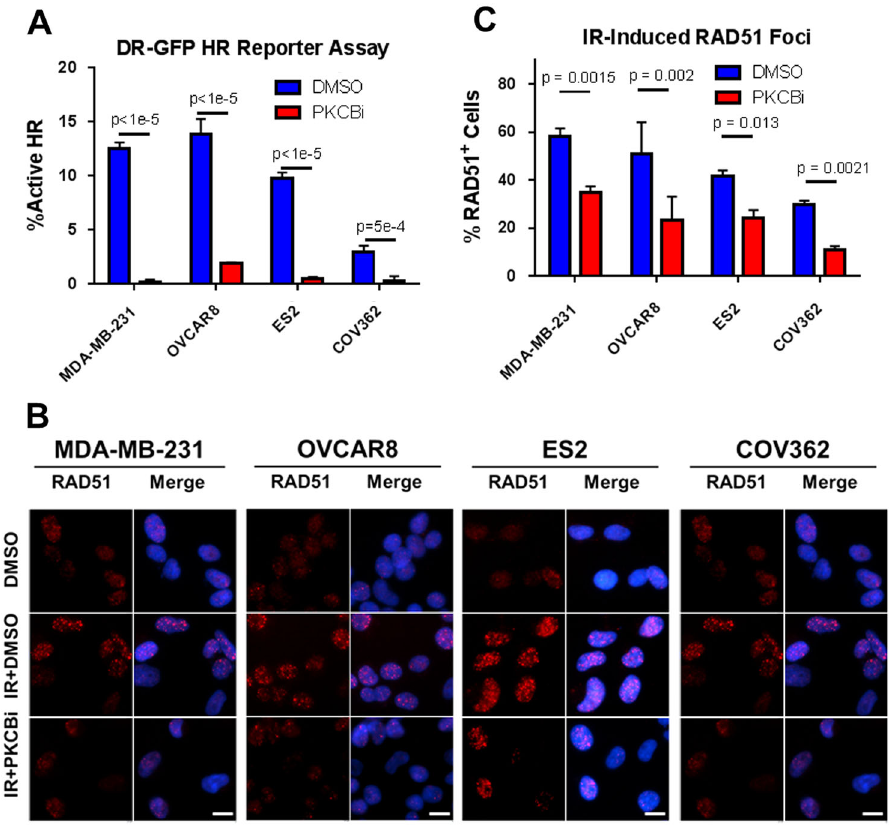
Fig. 5 PKC β inhibition induces de fi ciencies in homologous recombination. a DR-GFP homologous recombination (HR) reporter assay, where GFP induction is induced in cells with active HR following dual transfection with the DR-GFP and the pCBA-SceI. The day after transfection, cells were treated with either 5 μ M LY317615 or DMSO vehicle control for 48 h. The percentage of cells with active HR was calculated as the percentage of DR-GFP positive cells normalized to percentage GFP positive cells transfected with an equimolar amount of pEGFP-C1. b Reduction in radiation-induced Rad51 foci formation shows inhibited HR. Cells were pre-treated with 5 μ M LY317615 for 4 h, irradiated at 5 Gy, and then allowed to recover for 4 h before immunostaining for Rad51 ( red ) and nuclei ( blue ). Scale bar = 10 μ m. c Quanti fi cation of images in 5b, when considering that cells with more than 10 Rad51 foci are deemed as being